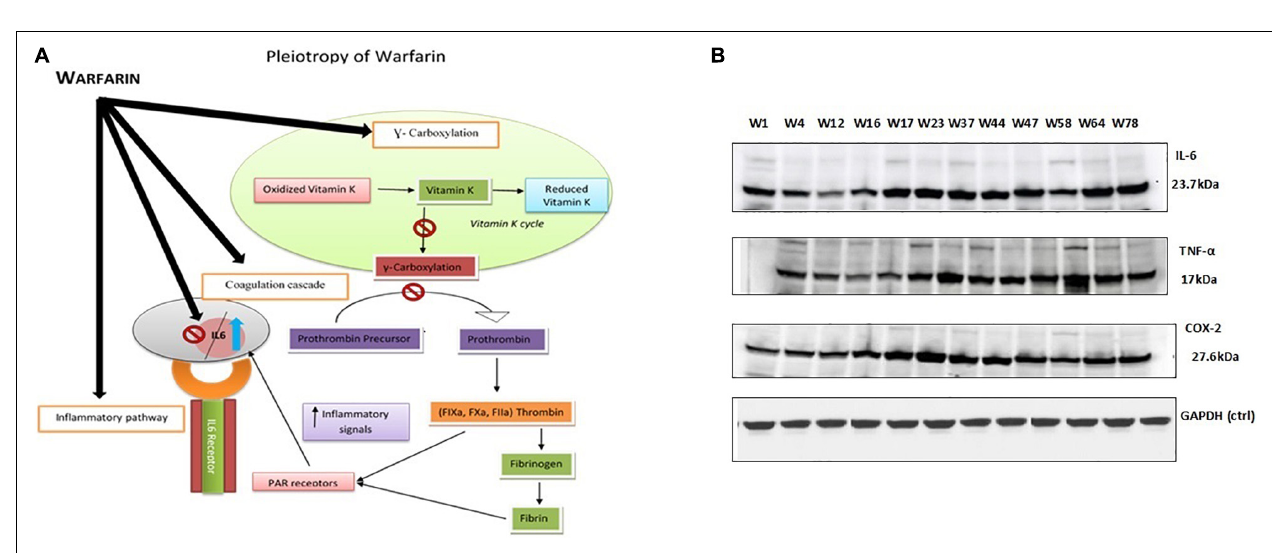
FIGURE 6 | (A) TNF- α mRNA expression on low warfarin dose. Samples are plotted on the x -axis and RQ on the y -axis. Each bar shows the set of sample values of a detector. The detector for the TNF- α gene is shown in blue. The error bars show the RQ min/max expression levels that measured the standard error of the mean expression level (RQ value). (B) COX-2 mRNA expression on low warfarin dose. The detector for COX-2 gene is shown in green. The error bars show the RQ min/max expression levels that measured the standard error of the mean expression level (RQ value). (C) Association of IL-6, COX-2, and TNF- α serum levels with warfarin dose: Serum IL-6, COX-2, and TNF- α levels were detected by ELISA with different warfarin doses (2.5, 5, 7.5, 10, 12.5, and 15) mg/day and compared with Control. (D) COX-2 mRNA Expression on high warfarin dose. Samples are plotted on the x -axis and RQ on the y -axis. Each bar shows the set of sample values of a detector. The detector for the COX -2 gene is shown in blue. The error bars show the RQ min/max expression levels that measured the standard error of the mean expression level (RQ value).